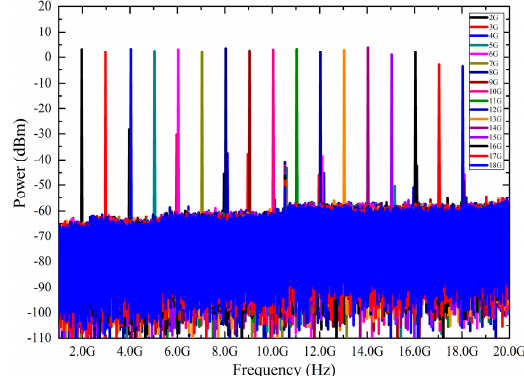
Figure 5. The generated signal spectrum with tunable frequency range from 2 GHz to 18 GHz.